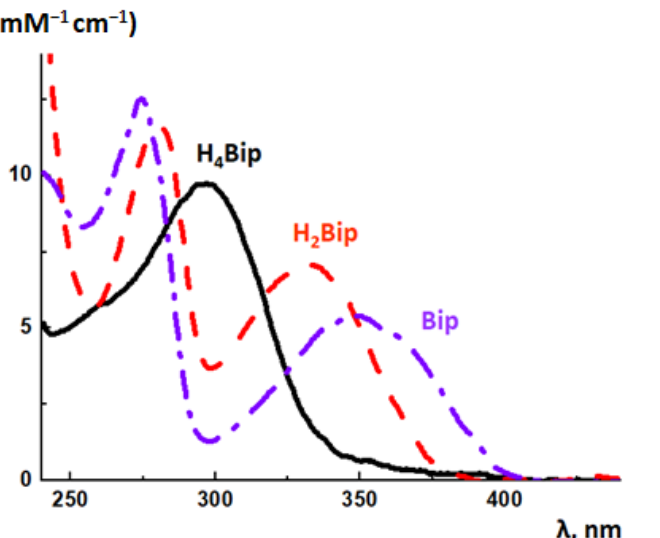
Figure 14. Absorption spectra of 5,6,7,8-tetrahydrobiopterin (H 4 Bip), 7,8-dihydrobiopterin (H 2 Bip) and biopterin (Bip)